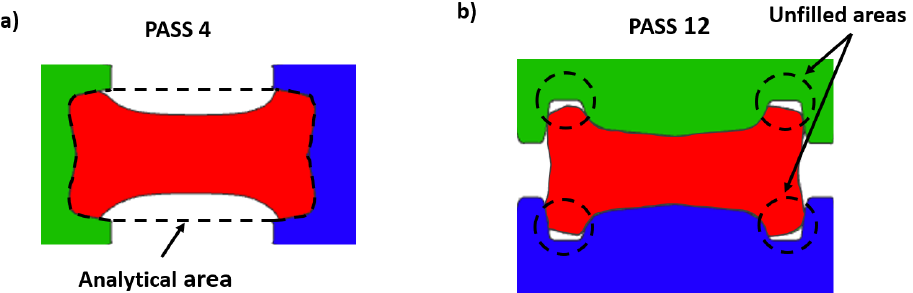
Figure 5. ( a ) Orientation of the beam in pass number 4; ( b ) unfilled areas at the grooved rolls during pass number